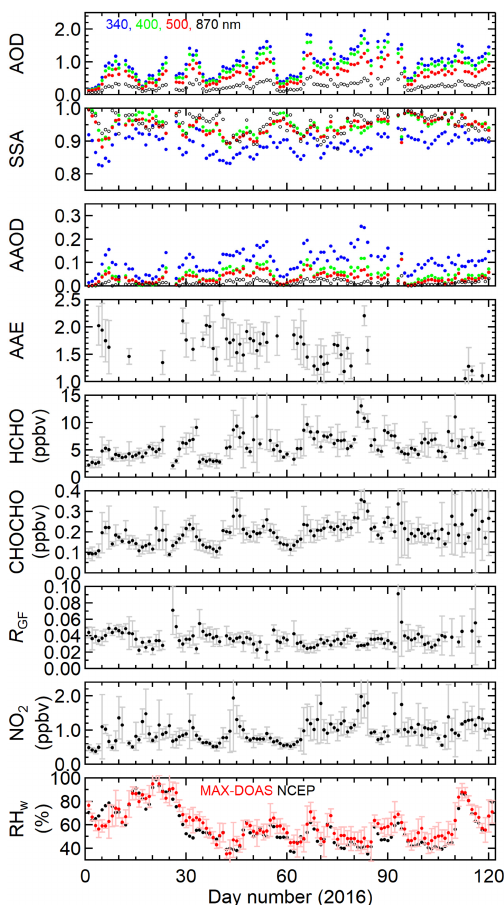
Figure 1. Time series of multiple components retrieved from sky radiometer and MAX-DOAS observations at Phimai, Thailand, for the intense BB period from January to April 2016. Daily means for 09:00–15:00LT are plotted. Their 1 σ standard deviations are shown by error bars. AOD, SSA, and AAOD values for different wavelengths are shown in different colors. For RH w , red symbols indicate MAX-DOAS-derived RH w for a layer of 0–1km and black symbols indicate the surface RH w from NCEP